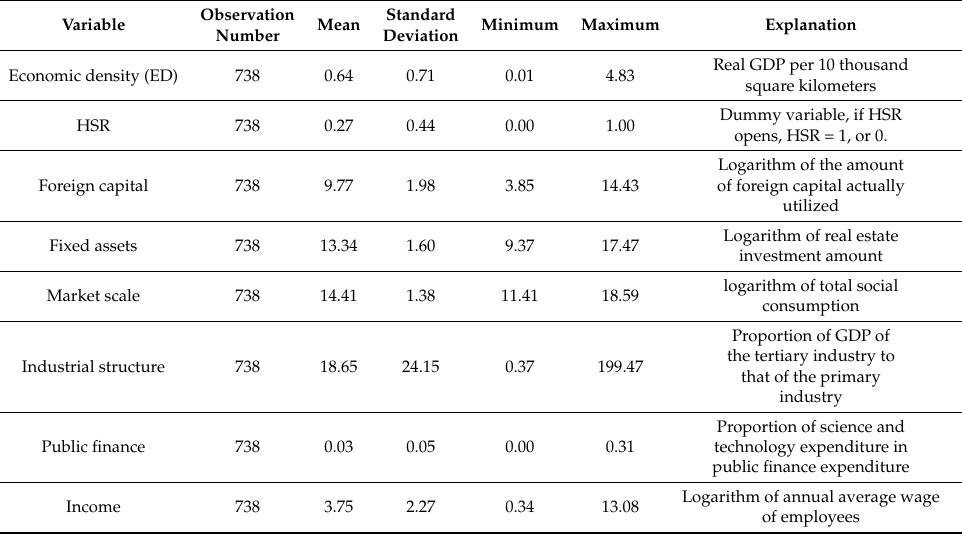
Table 1. Descriptive statistics of main